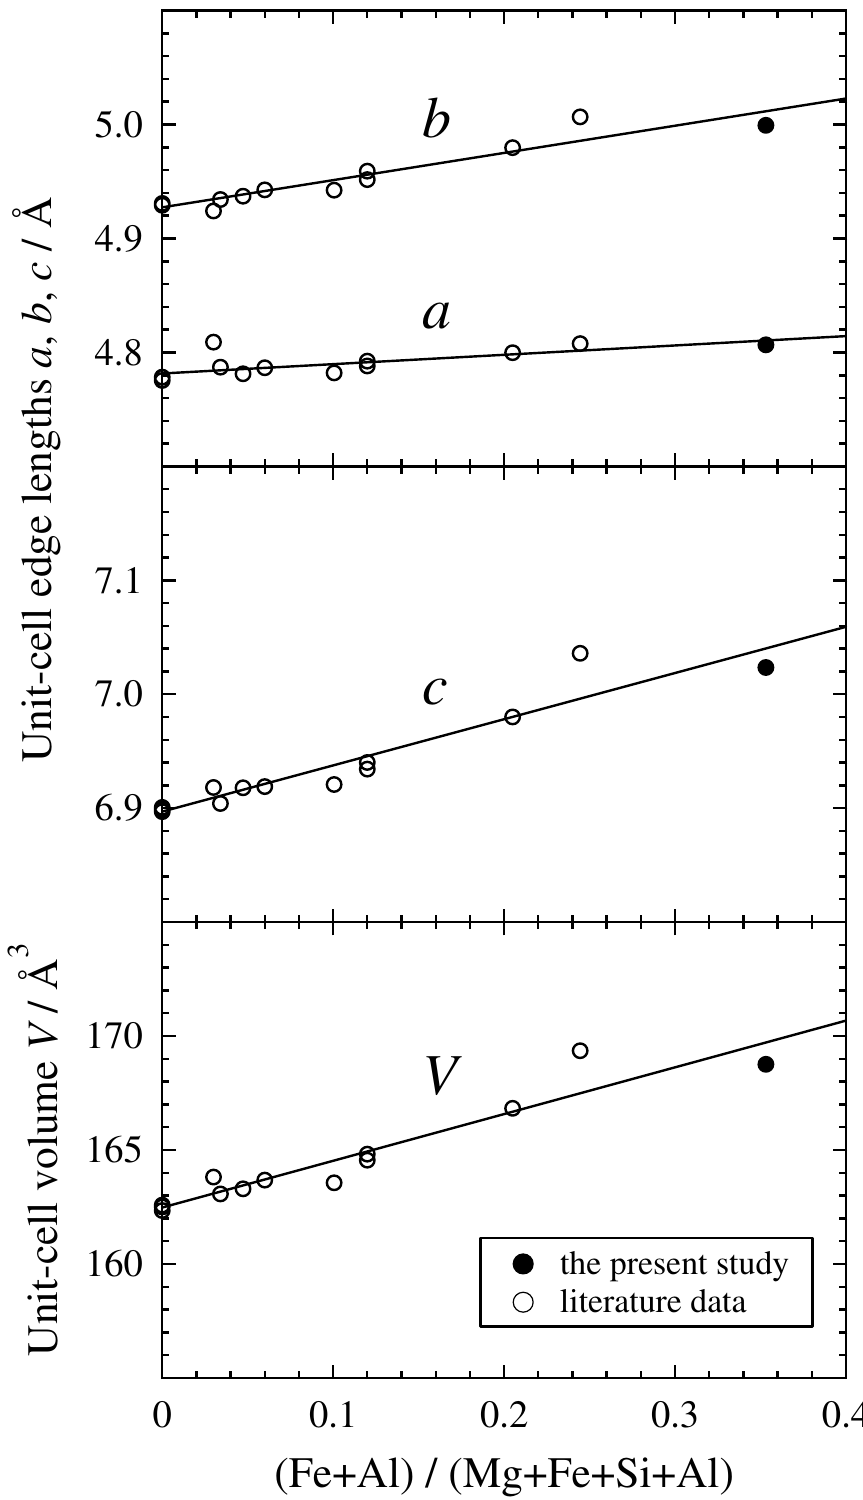
Figure 3. Unit-cell edge lengths ( a , b , c ) and volume ( V ) as a function of the cation ratio (Fe + Al)/ (Mg + Fe + Si + Al). The literature data of the end-member MgSiO 3 bridgmanite 10, 45, 46, 61 and the (Fe, Al)-bearing bridgmanites 3, 4, 6, 7, 10 with near contents between Fe and Al are represented together with the present data. The data graphing software used is as in Fig.